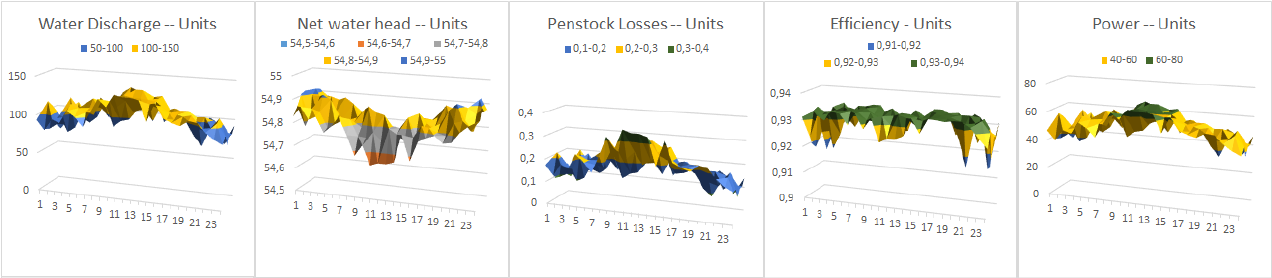
Figure 11. CRO with DE Mutation (best/1/bin)— CRO ( 2 b ) . Results of Water discharge (m 3 /s). Net water head (m). Penstock